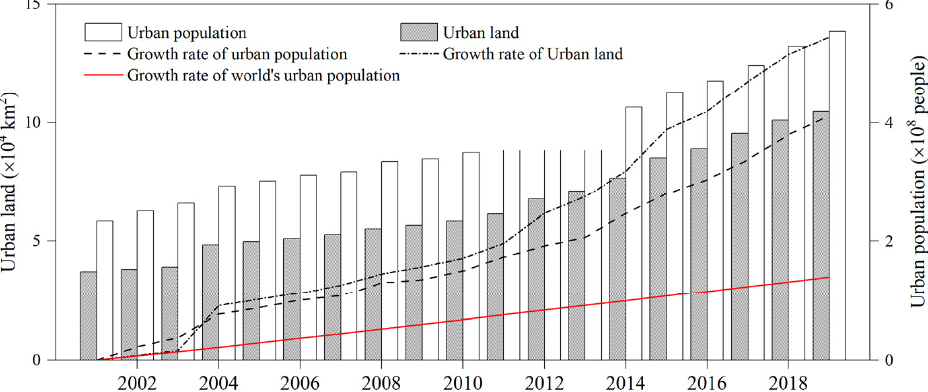
Figure 8. Temporal change of urban population and urban land in Africa from 2001 to 2019. Note: the growth rate was calculated based on 2001.